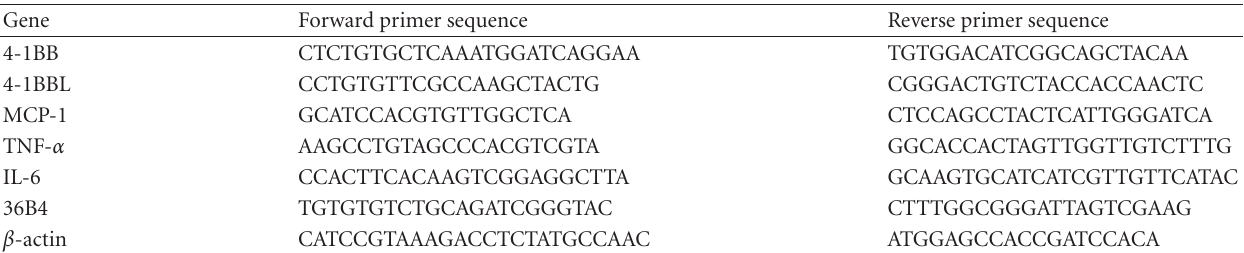
Table 1: Sequences of mouse primers used for qRT-PCR